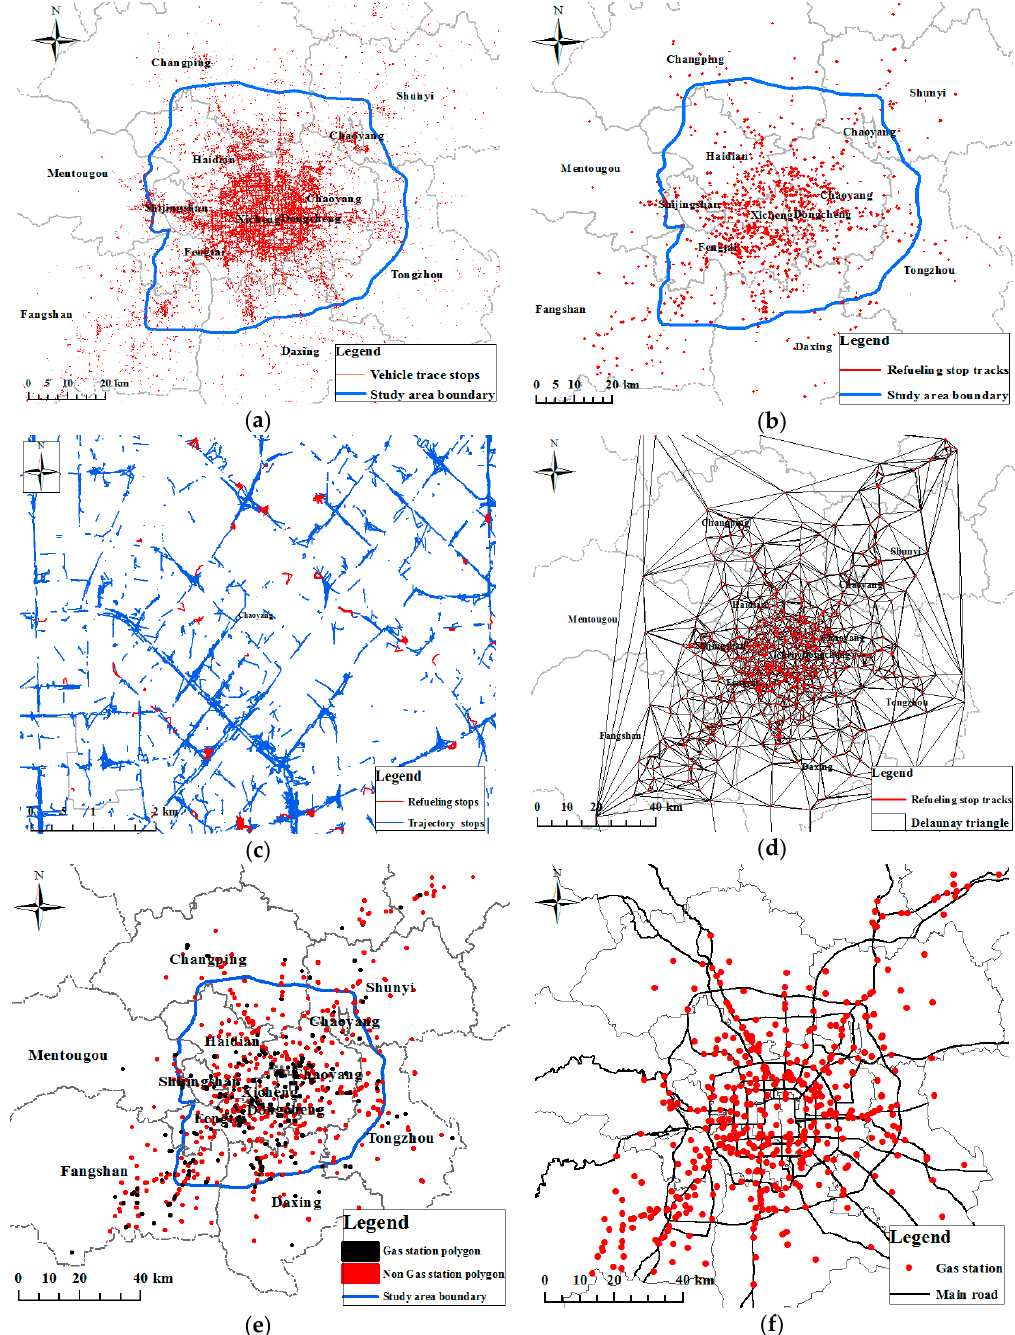
Figure 9. The process of gas station extraction and the results. ( a ) Extracting stops from one day vehicle traces by step 4 of the VSLC; ( b ) Refueling stops extraction from Figure 9a by step 5 of the VSLC; ( c ) Extracting refueling stops (part); ( d ) Constructing the Delaunay triangulation using collective stop tracks; ( e ) Gas station polygon extraction; ( f ) Experimental results.